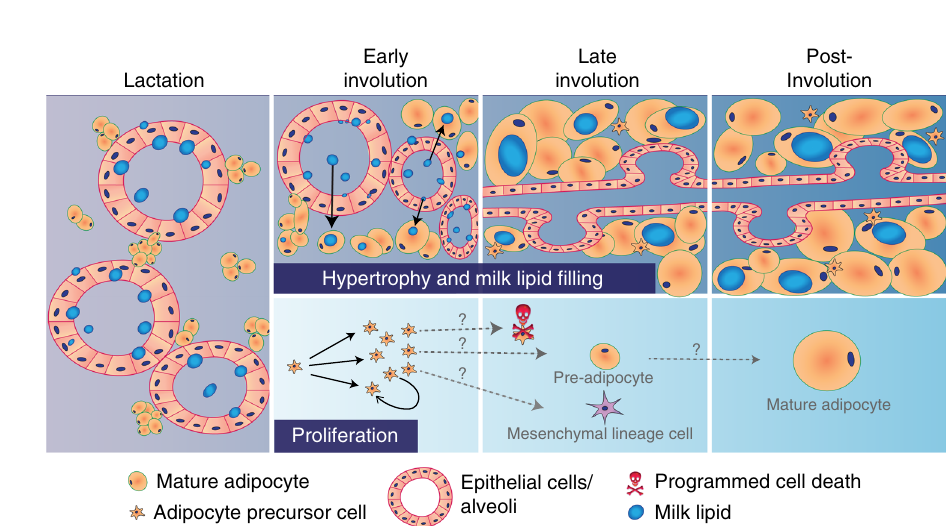
Fig. 7 Model of adipocyte hypertrophy, lipid traf fi cking, and adipocyte precursor cell proliferation during lactation and involution. (Top) Mature adipocytes present in the mammary gland (MG) during lactation undergo hypertrophy and fi ll with milk lipids as epithelial alveoli regress during early involution. By late involution, a mammary fat pad consisting of long-lived adipocytes containing epithelial-derived lipid surrounds the remodeled epithelial ducts. (Bottom) Adipocyte precursors (APs) also proliferate during early involution. Several possible outcomes for newly formed cells during late